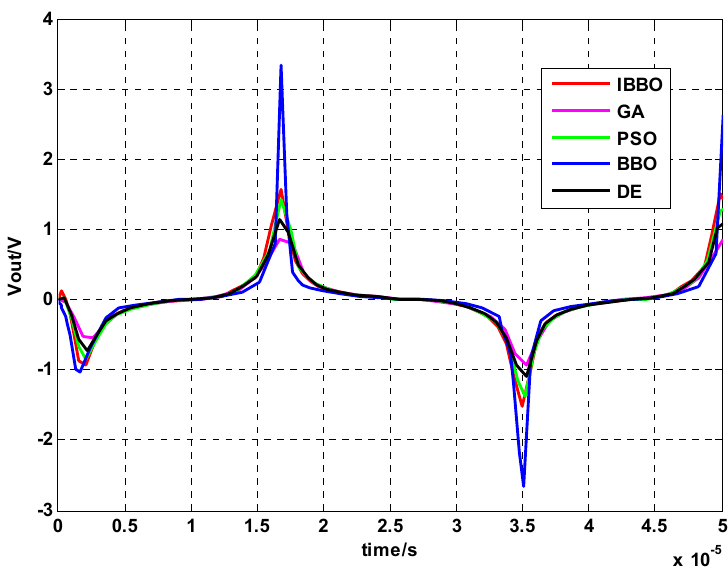
Figure 9. Simulation outputs of fluxgate probe.